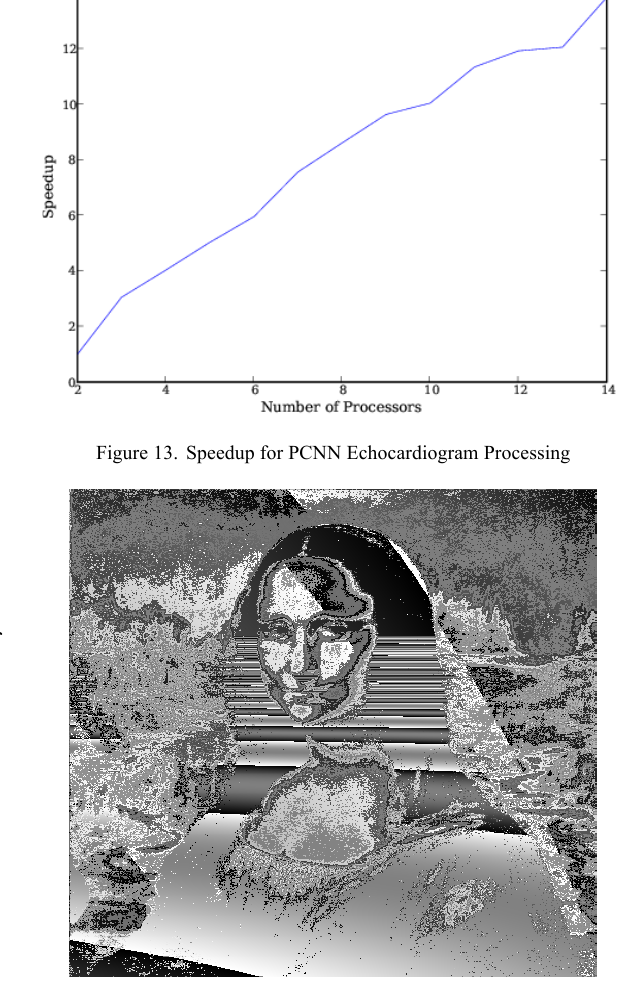
Figure 14. Genetic Programming for Visual